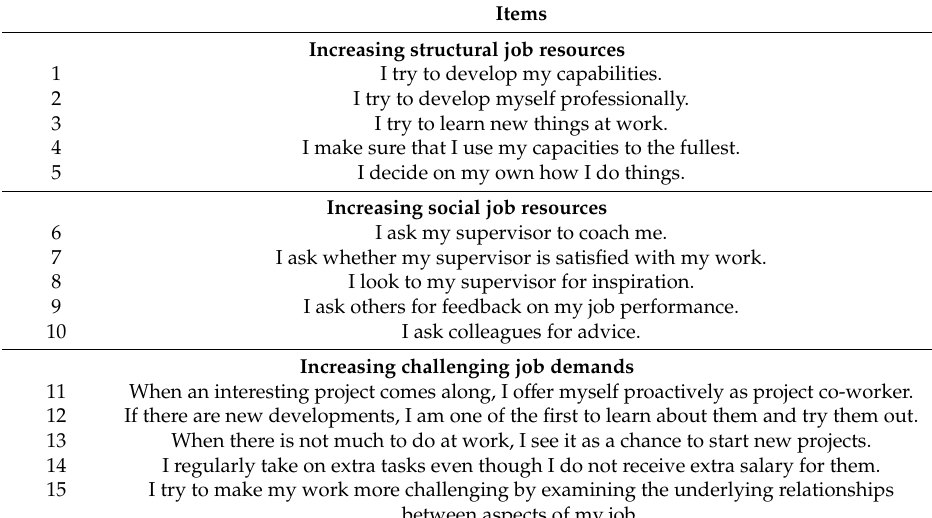
Table 2. Positive individual job